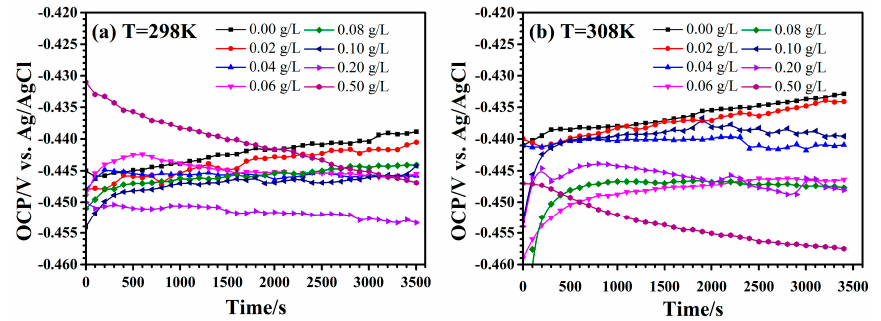
Figure 1. Molecular structures of ( a ) ursolic acid; ( b ) oleanolic acid; and ( c )